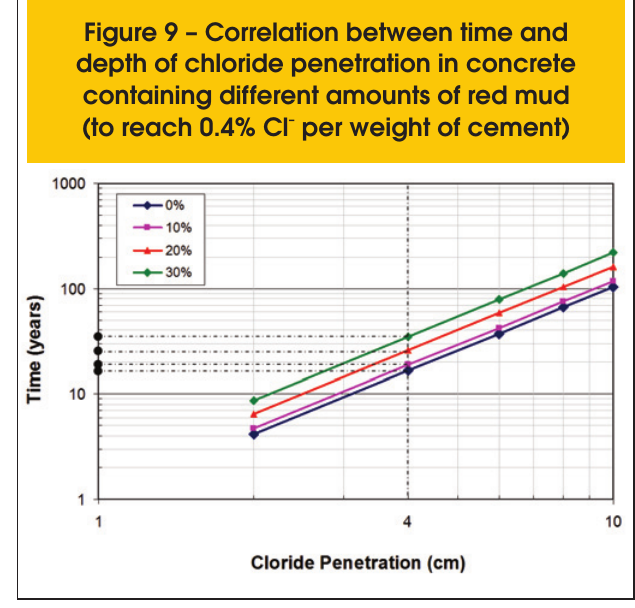
Figure 9 – Correlation between time and depth of chloride penetration in concrete containing different amounts of red mud – (to reach 0.4% Cl per weight of